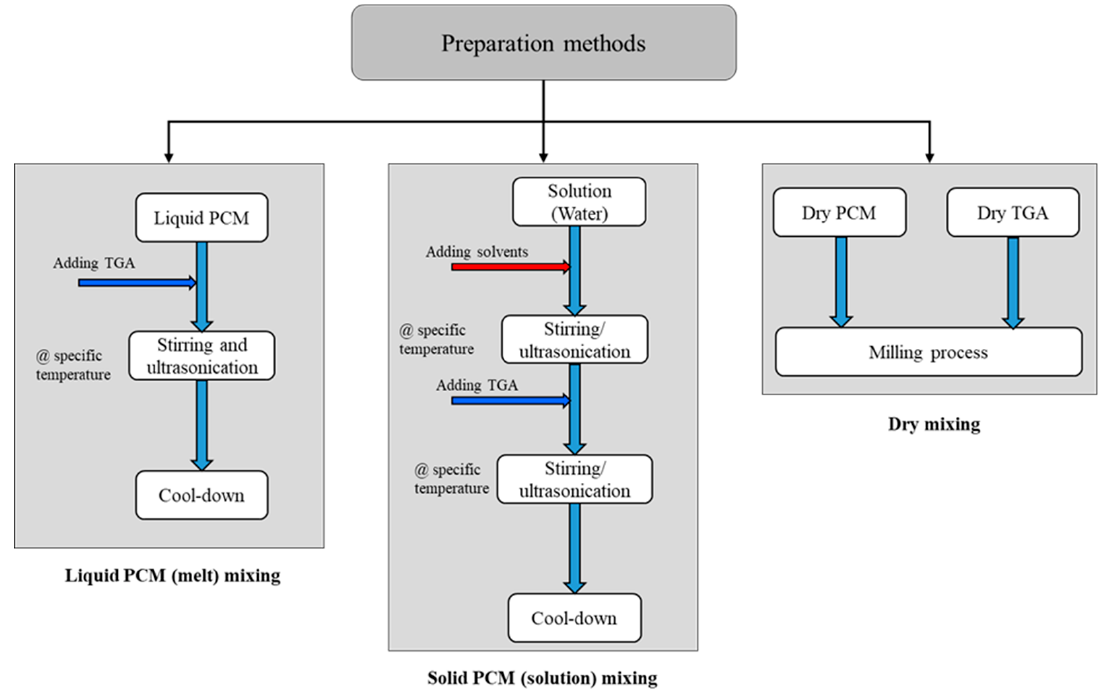
Figure 6. PCM + GTA preparation approaches